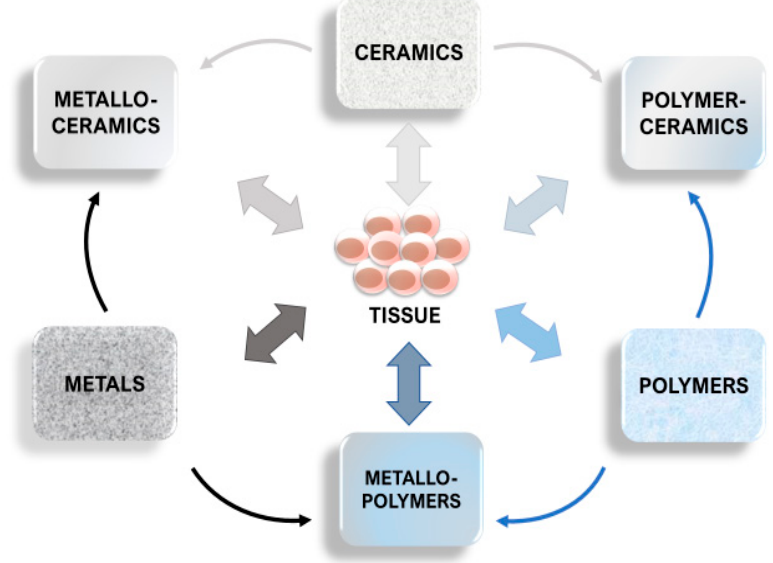
Figure 1. Implant types by materials. While most research focuses on tissue interaction with a single type of material, currently, the variety of available compound materials allows us to modify the material properties and their behaviour according to requirements.